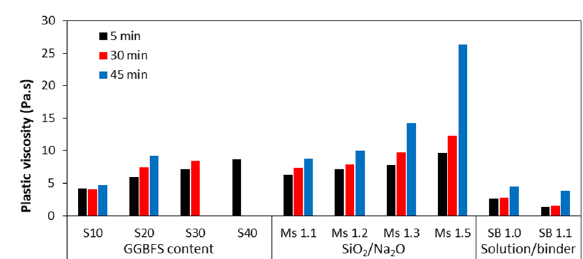
Figure 5. Plastic viscosity of AAM pastes at different elapsed